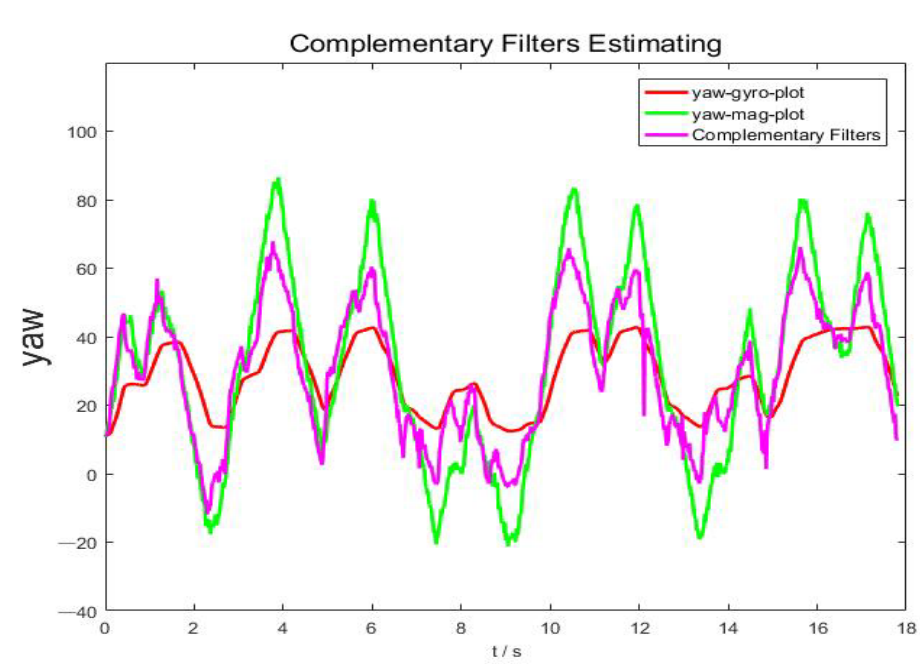
Figure 16. MPU9250 dynamic result after CF data fusion.